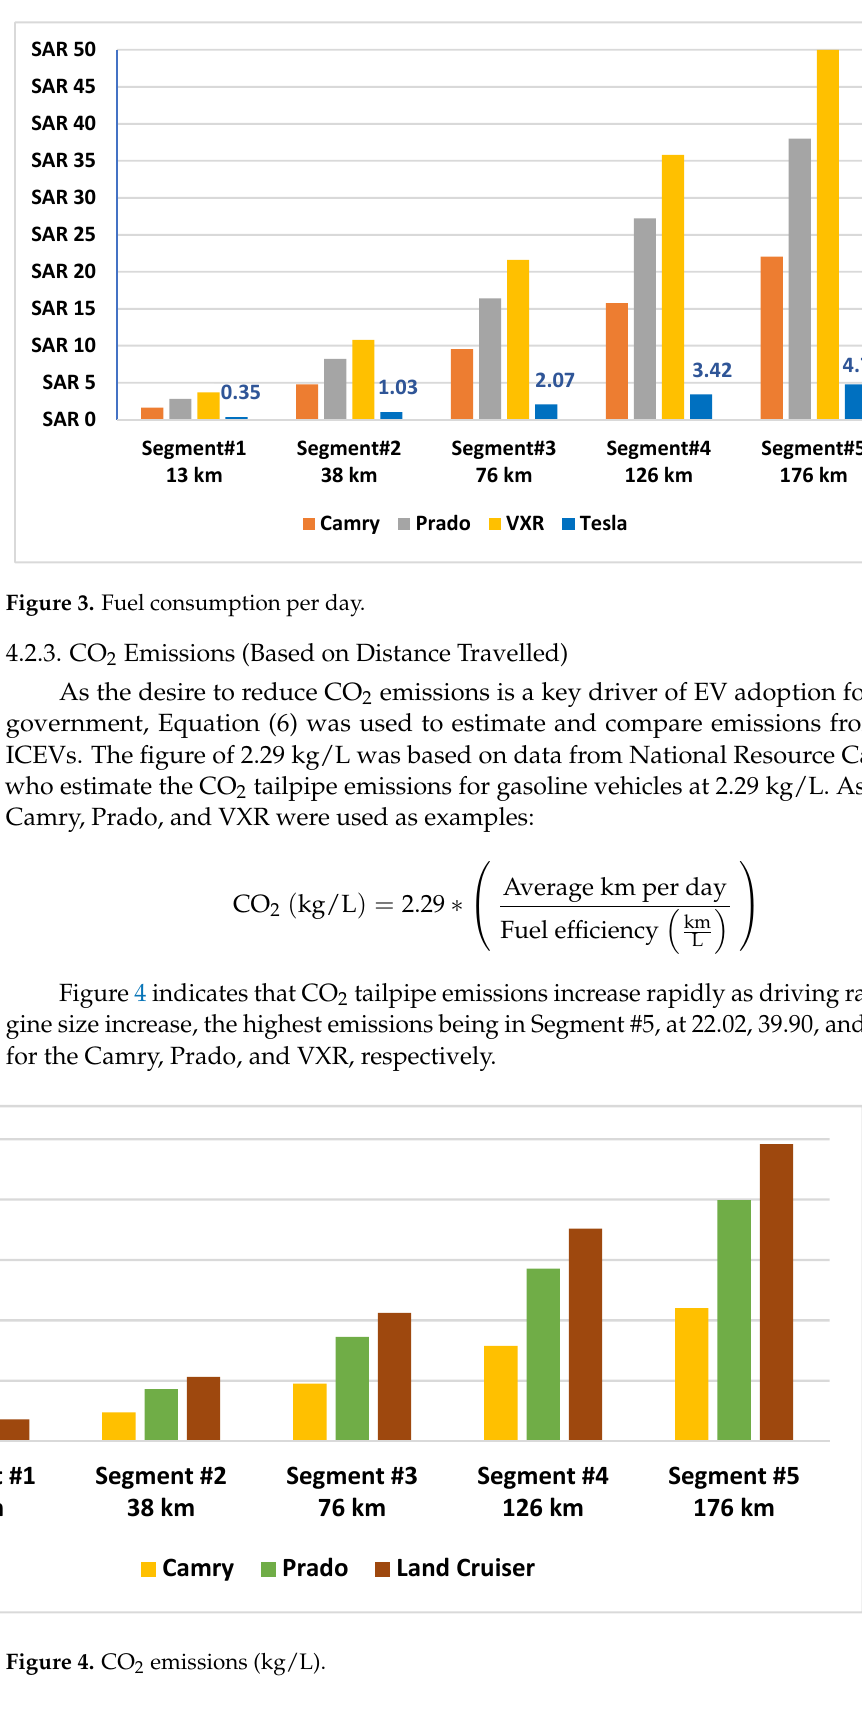
Figure 4. CO 2 emissions (kg/L).